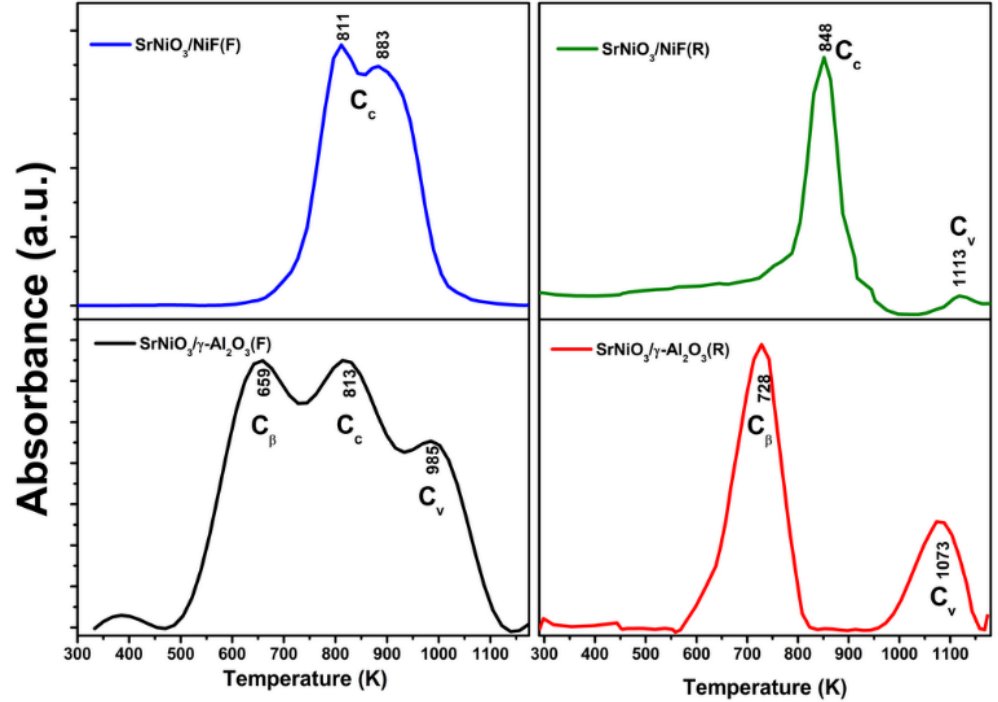
Figure 13. Temperature-programmed oxidation (TPO) profiles of used catalysts after DRP over 50 h.